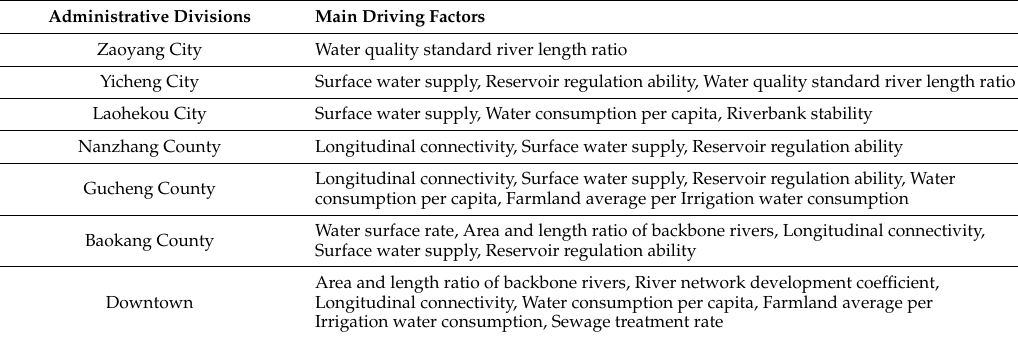
Table 6. Main driving factors for each region in Xiangyang city.